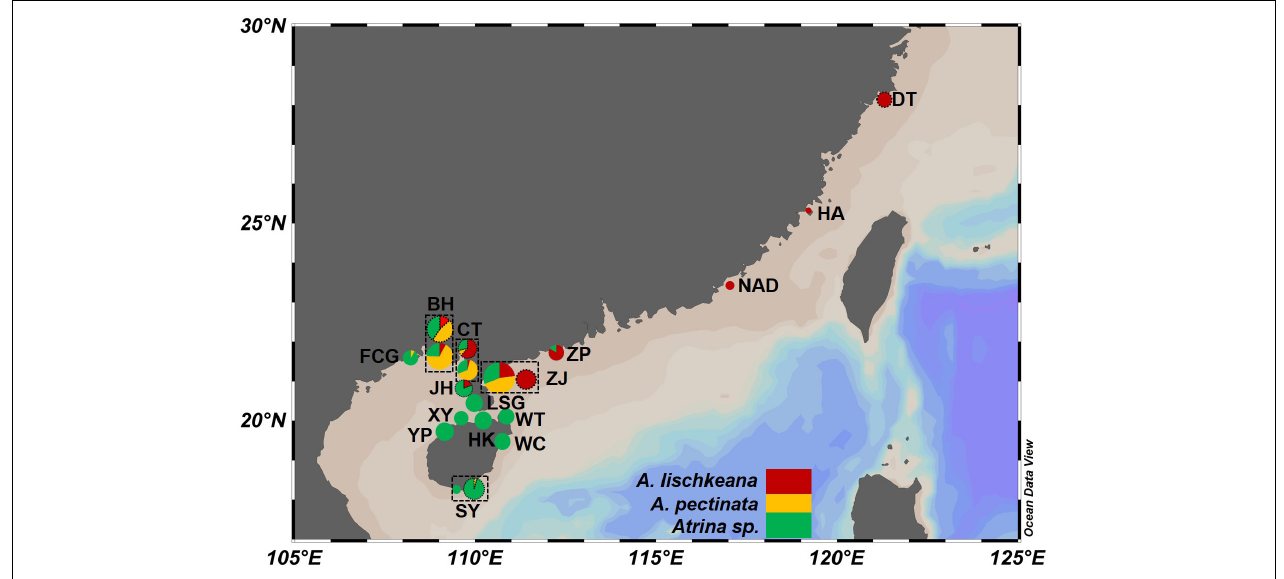
FIGURE 1 | Map of the sampling localities and distribution of the three putative species in the A. pectinata species complex along the coasts of southern China. Sampling sites are labeled with abbreviations in Table 1 . The accompanying pie charts with different colors indicate their topological placement among the three putative species for each locality. Dotted circles of sampling localities showed that the sequences of these populations were retrieved from GenBank.